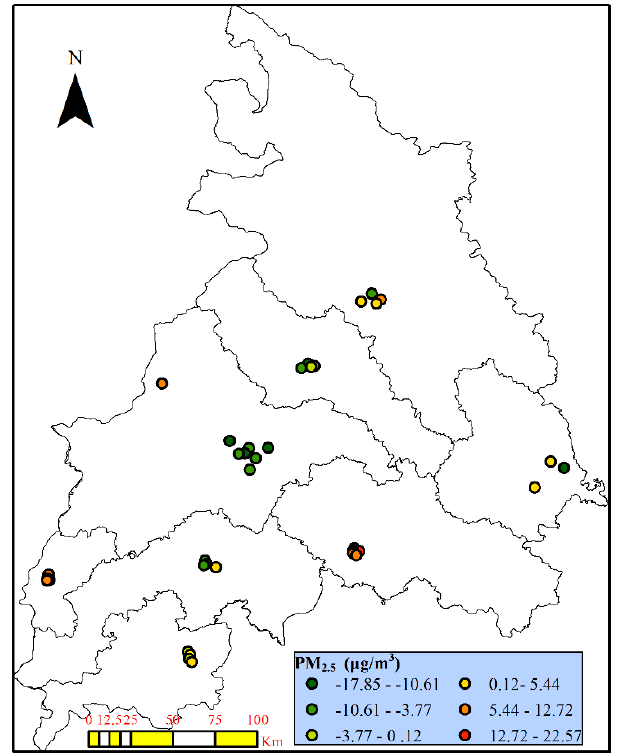
Figure 4. The di ff erences between estimated and measured PM 2.5 ( µ g / m 3 ) at each monitoring site Figure 4 . The differences between estimated and measured PM 2.5 ( μ g/m 3 ) at each monitoring site during during 2015